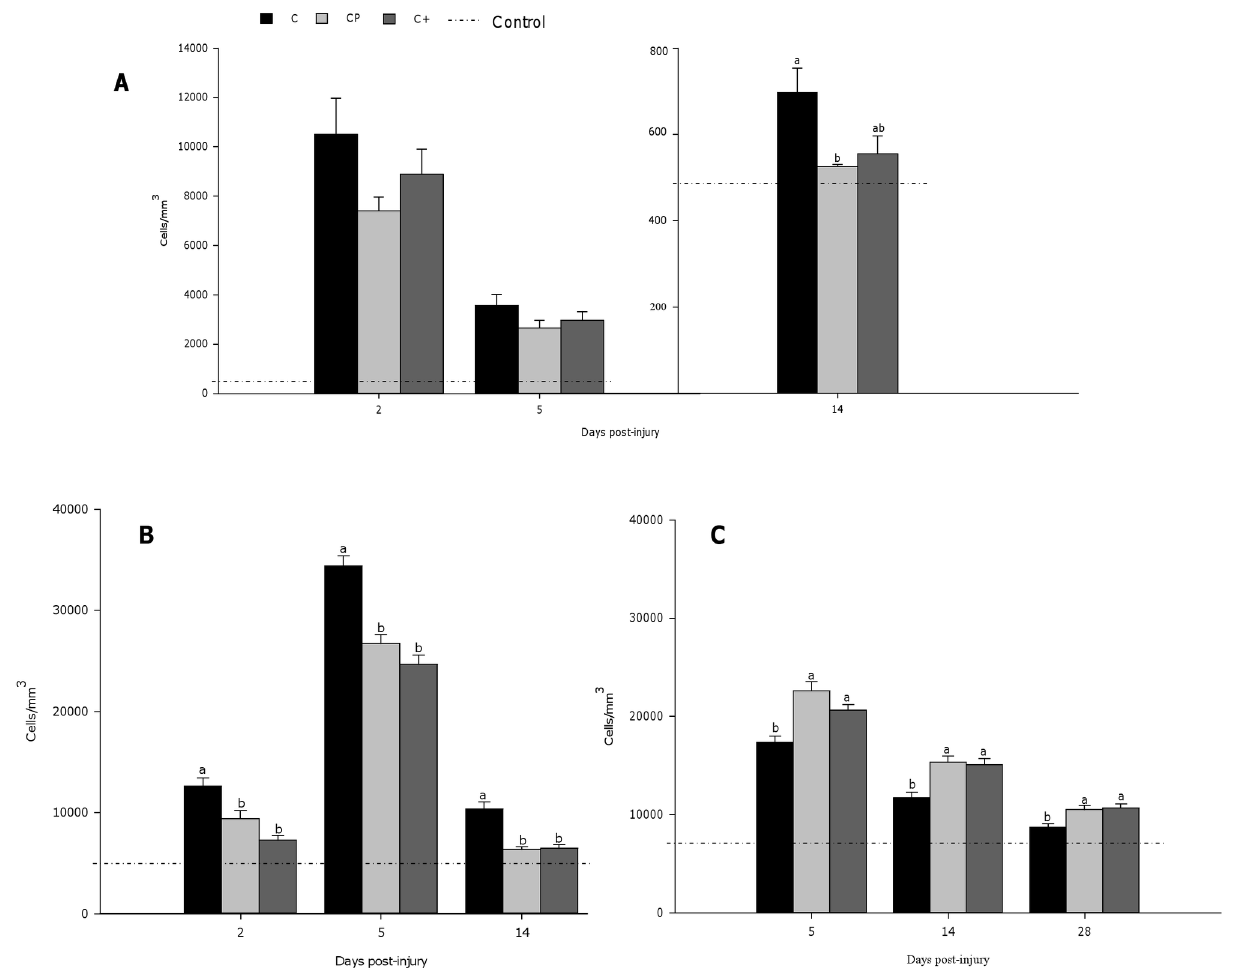
Figure 4. Time course of inflammatory cell accumulation in rat tibialis anterior muscle following bupivacaine injection. Transverse sections (10 µm) were immunoassayed with specific antibodies against neutrophils (W3/13) (A), ED1 + - macrophages (B), or ED2 + -macrophages (C). Labeled cells were counted at 400X magnification, and expressed as a number of cells/mm 3 . Values are mean ± SEM (n = 7-8 rats per dietary group/time point). As a control, values for neutrophils and macrophages at T0 are indicated by the dotted line. Groups bearing different letters for a given time point are significantly different (p≤0.05). C, casein; CP, cod protein; C + , casein supplemented with L-arginine, glycine, L-taurine and